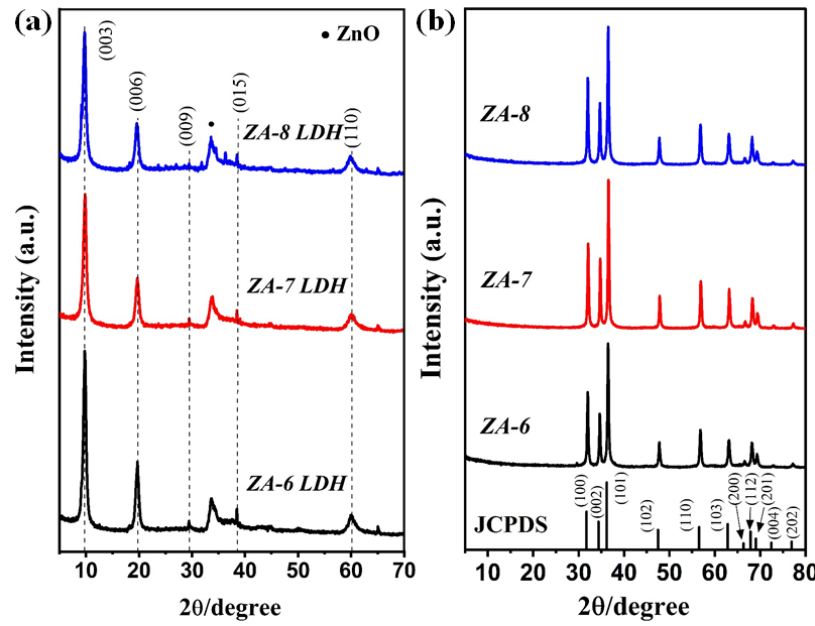
Figure 2. XRD patterns of ( a ) pristine LDH and ( b ) ZA-m ; where m represents the molar ratio. Table 1. In-depth XRD parameters of the prepared Zn(Al)O-MMO Nanorods (ℎ𝑘𝑙 = 101) .